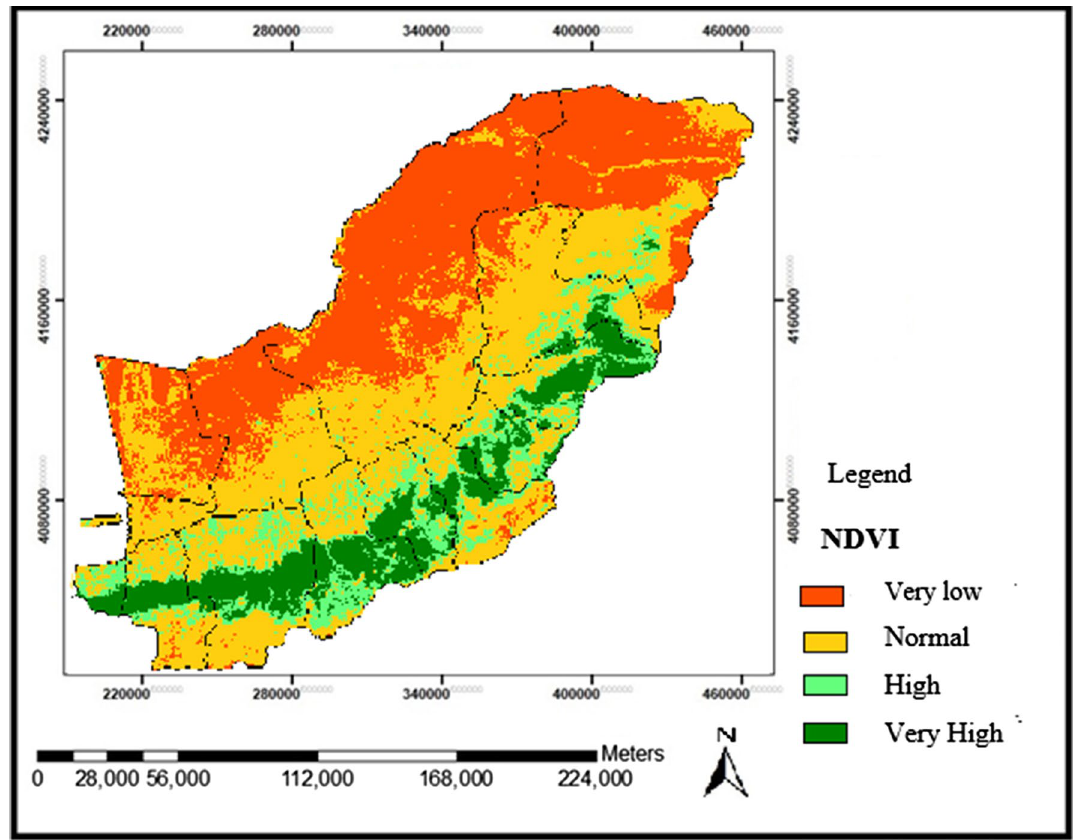
Fig. 4 Average NDVI of Golestan province in the months of plant growth from 2005 to 2020